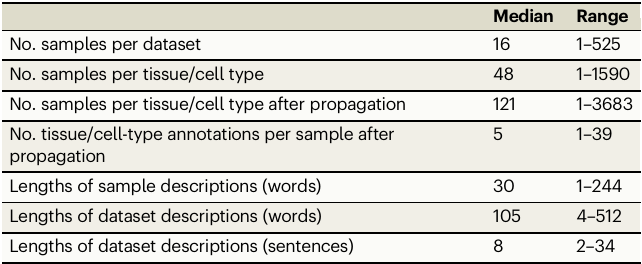
Table 1 | Summary of tissue/cell-type gold-standard size and attributes of the associated sample and dataset metadata